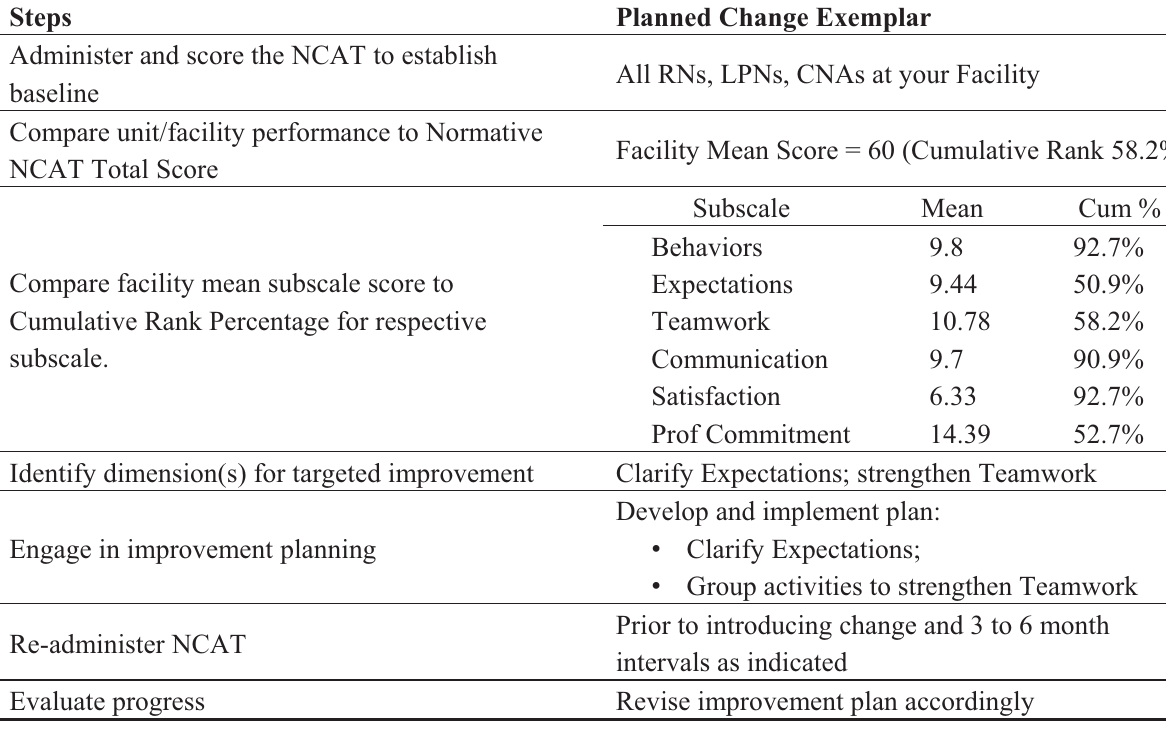
Table 5. Steps for Guiding Implementation of a Planned Change